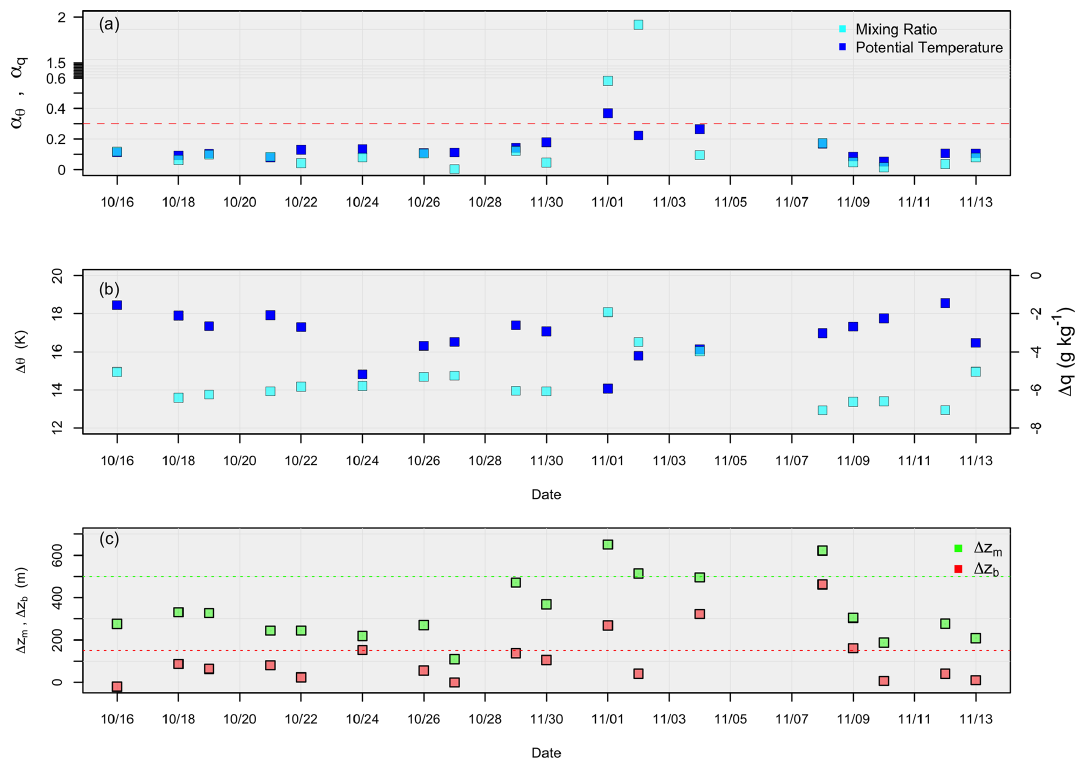
Figure 6. (a) θ (left y axis, dark blue) and q (right y axis, light blue) differences across the inversion for all 18 flights. (b) The decoupling parameters for mixing ratio (light blue) and potential temperature (dark blue); the red dashed line represents the 0.30 value. (c) Mixed layer cloud thickness (green) and the difference between cloud base and the LCL (red); the red dashed line represents the 500 value, and the green dashed line represents the 150